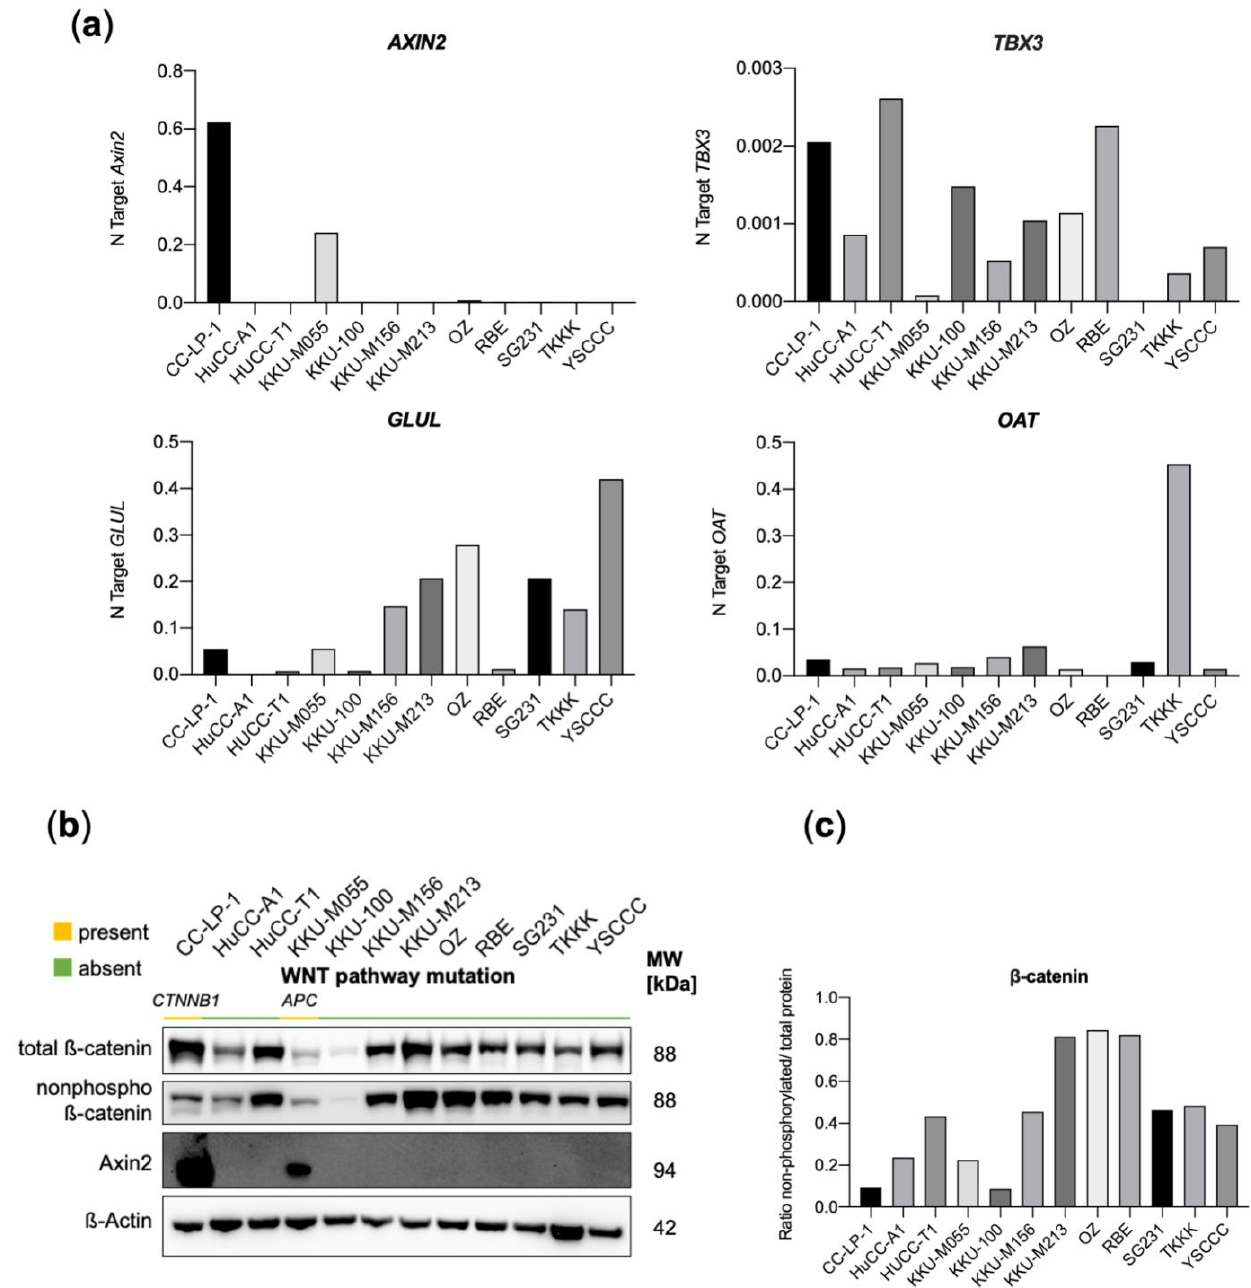
Figure 5. ( a ) Quantitative real-time PCR analyses of Axin2 , TBX3 , GLUL , and OAT mRNA levels in CCA cell lines. Quantitative values are expressed as number target (N Target). N Target = 2 − ∆ Ct , wherein the ∆ Ct value of each sample was calculated by subtracting the average Ct value of the gene of interest from the average Ct value of the GAPDH gene. ( b ) Western Blot analysis of total β -catenin, non-phospho β -catenin, and Axin2 with ( c ) respective band volume intensity ratios. No technical or experimental repeats of Western Blots were performed ( n = 1). MW, molecular